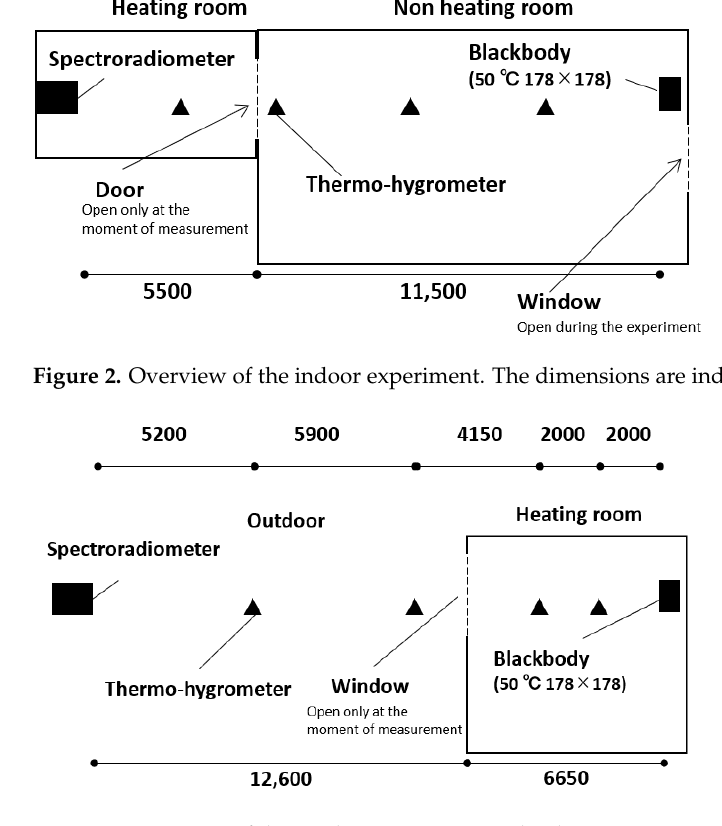
Figure 3. Overview of the outdoor experiment. The dimensions are indicated in